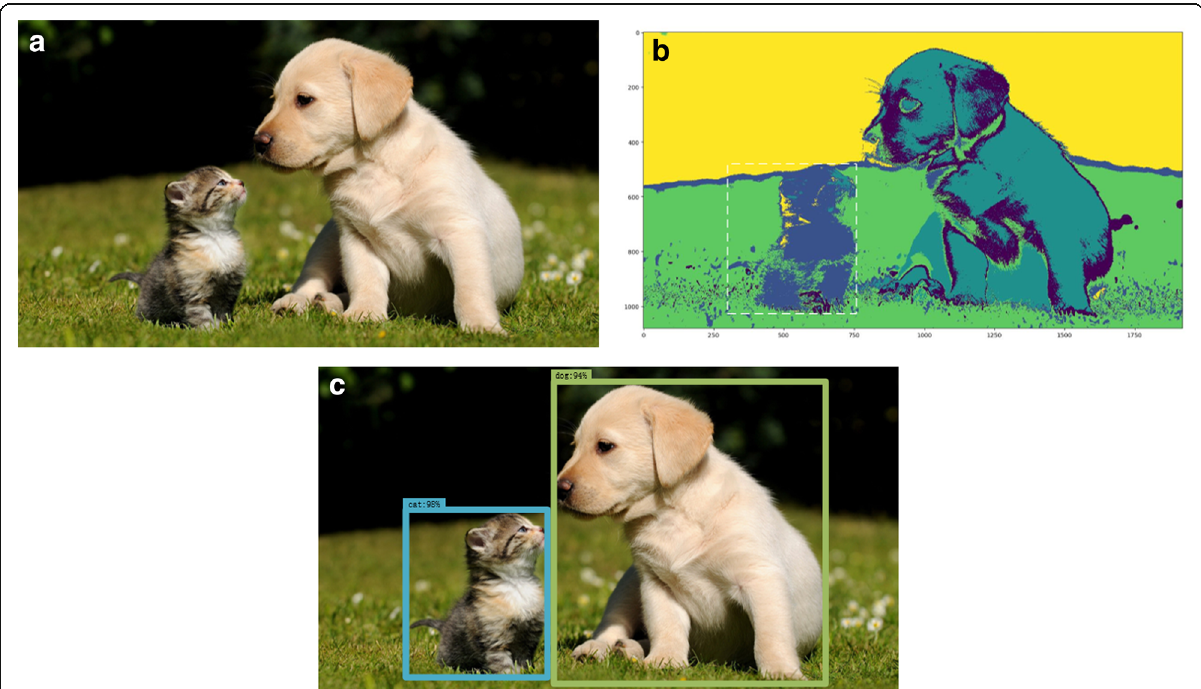
Fig. 1 A monitoring system with wireless sensor networks. Figure 1 shows a monitoring system with wireless sensor networks. a Original image. b Anchor box defining. c Object